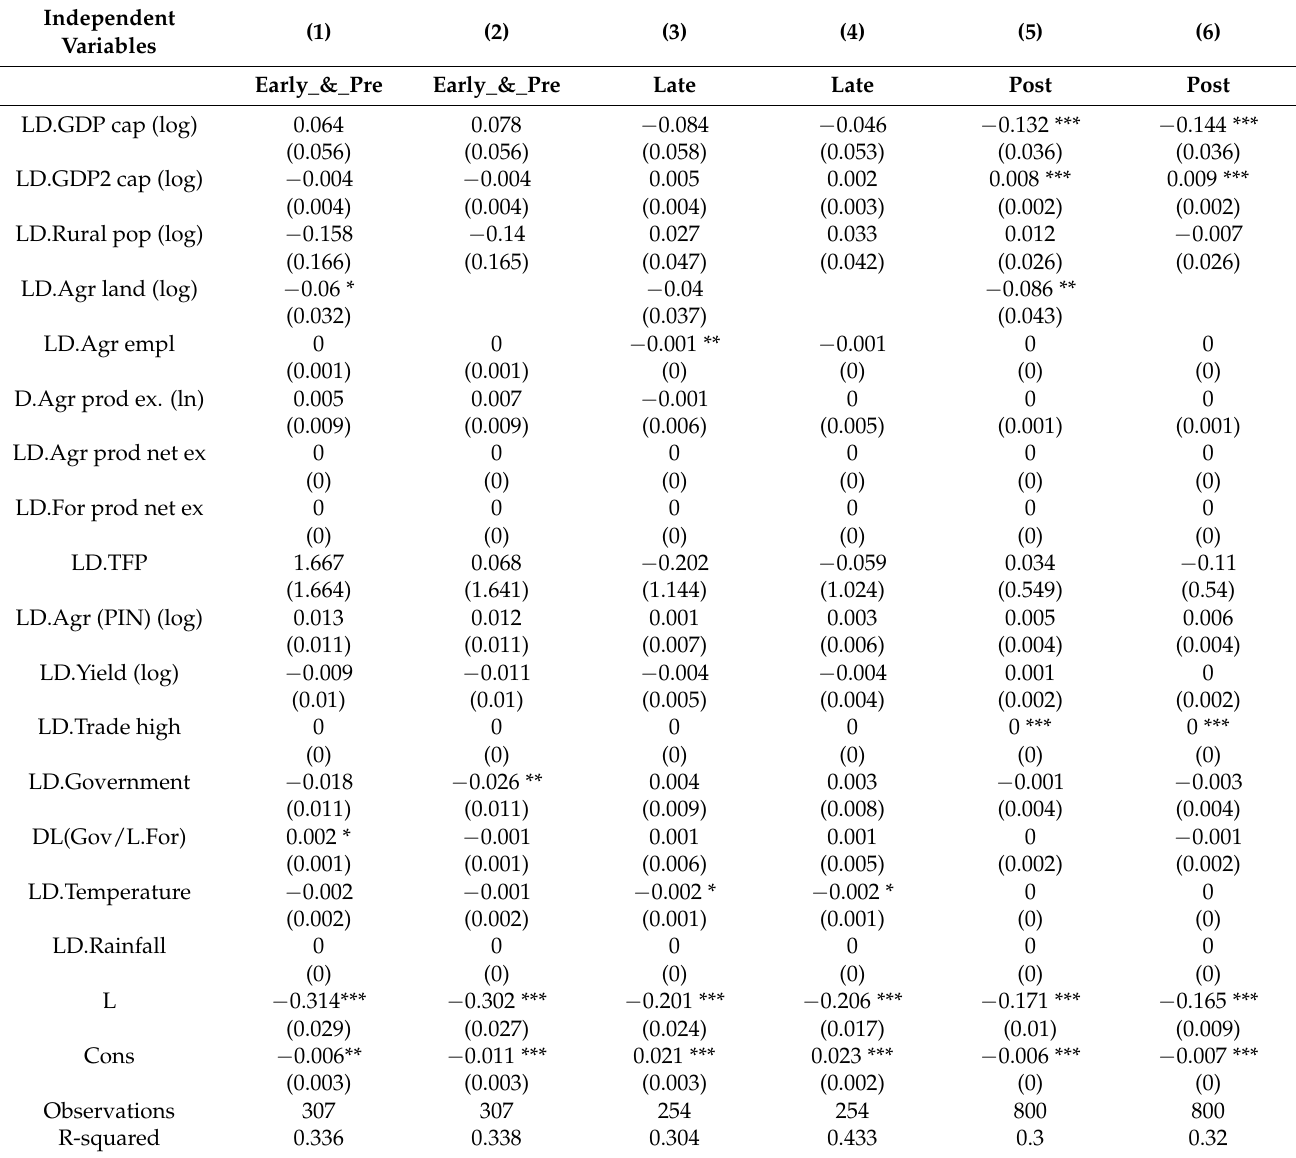
Table A5. Short run, forest transition clusters, net agricultural exports as additional control variable. Independent